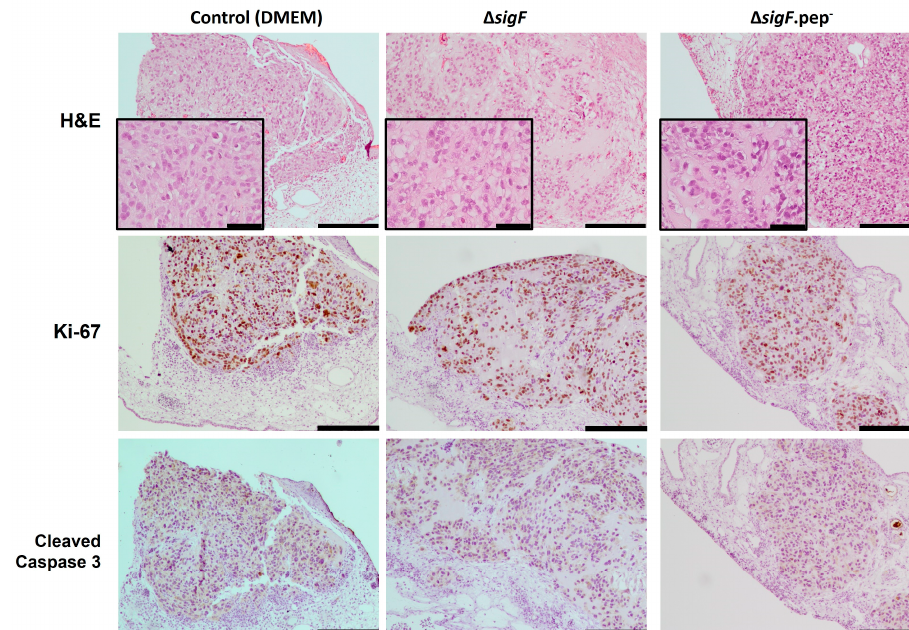
Figure 6. Representative images of the excised tumor xenografts from CAM after treatment with polymers Δ sigF and Δ sigF .pep-, or with vehicle solvent (DMEM), stained with H&E, and immunostained for Ki-67 and cleaved caspase-3. Scale bar = 200 μ m (except in the insets of H&E, in which scale bar = 50 μ m).